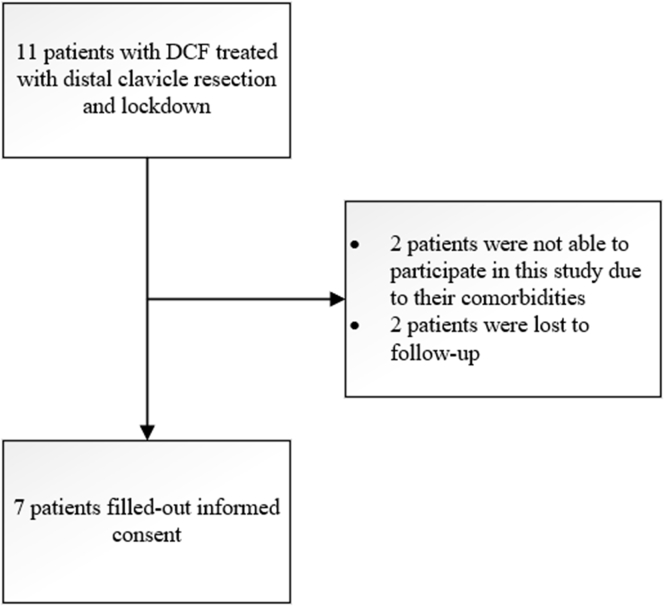
Inclusion of patients. At the time of inclusion, 2 patients were not able to participate in the study because they were undergoing treatment for malignancies. DCF, distal clavicle fracture.